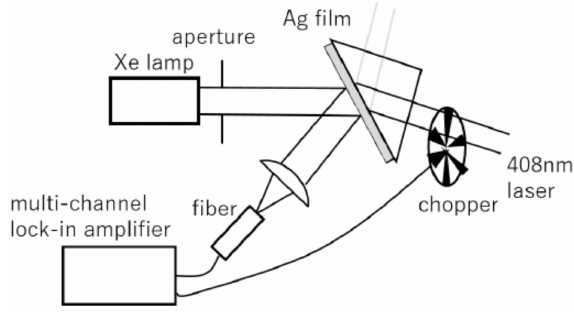
Figure 2. Experimental setup for the continuous wave (CW) plasmon modulation